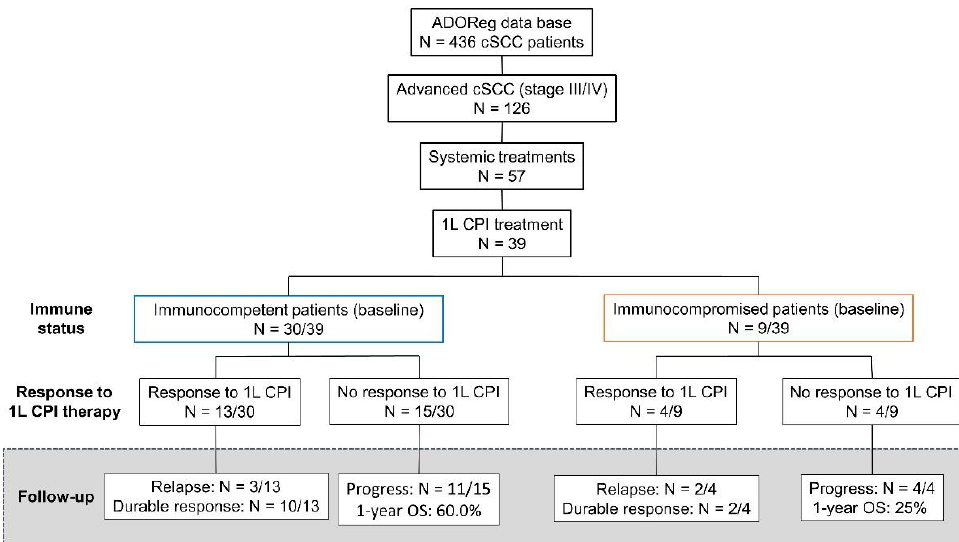
Figure 1. Flow chart depicting the selection criteria for this retrospective, multicenter analysis. We analyzed the outcome of patients with advanced cutaneous squamous cell carcinoma (cSCC) who were treated with first-line (1L) immune checkpoint inhibitors (CPI) at stratified outcomes based on the immune status at baseline. Patients without significant immunosuppression generally showed more durable tumor responses compared to immunocompromised patients despite similar rates of initial tumor responses. In the case of 3 patients with ongoing CPI therapy (2 among immunocompetent patients and 1 patient with baseline immunosuppression), no tumor assessments were available at the time of data cut-off.